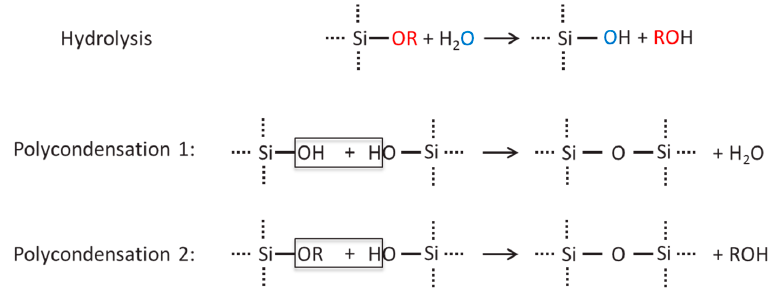
Figure 2. Mechanism of the hydrolysis and polycondensation reactions.